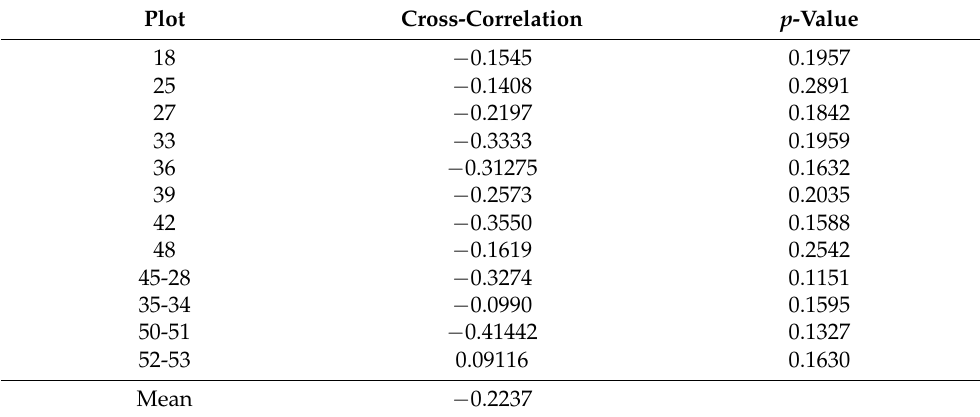
Table A1. Bivariate raster correlation using Dutilleul’s modified t -test for the data of ground cover and canopy cover at grid points. Plot Cross-Correlation p